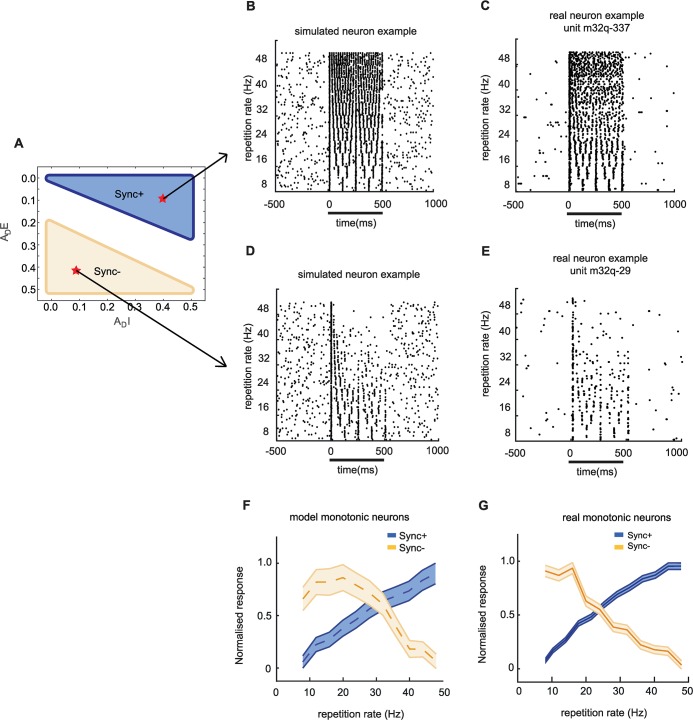
Real and Simulated monotonic Sync example neurons.(A.) Range amplitude of adaptation {ADE,ADI} that results in Sync+ and Sync- simulated responses. Raster plot comparison between simulated Sync+ (B; ADE = 0.4, ADI = 0.1, τpE = 0.15 s τpI = 0.10 s.) and Sync- (D; ADE = 0.1, ADI = 0.4, τpE = 0.15 s τpI = 0.10 s.) neurons with real Sync+ (C; unit m32q-337) and Sync- (E; unit m32q-29) neuron examples. the black bar indicates the time during when stimuli was given as input. ADE = 0.4, ADI = 0.1, τpE = 0.15 s τpI = 0.10 s. (F,G.) Normalized discharge rate for Sync + and Sync- neurons across stimuli with different repetition rates. Discharge rate was normalized to the maximum value across stimuli. (F.) Population average of simulated Sync+ and Sync- neurons. (G.) Population average of real Sync+ and Sync- neurons.